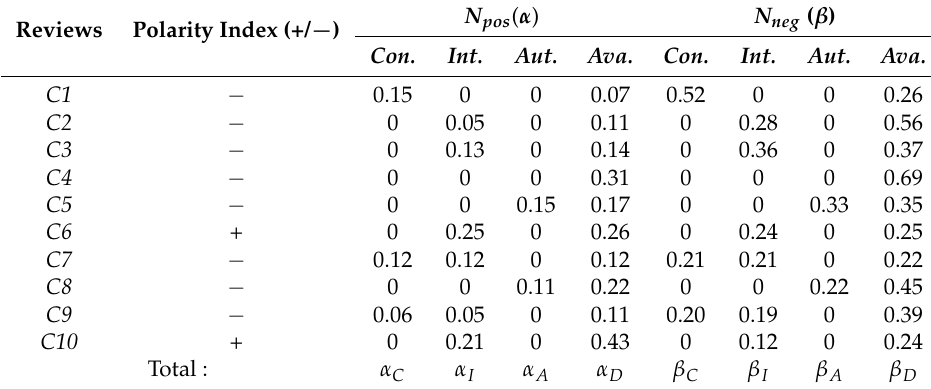
Table 3. Determination of ( α i , β i